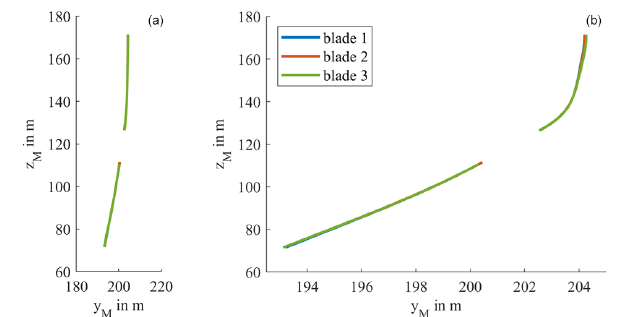
Figure 11. Blade deformation for different blades: fourth-degree polynomial fitted through all measurement points of the separate blades with (a) equal spacing between the y M and z M axis and (b) distorted view.